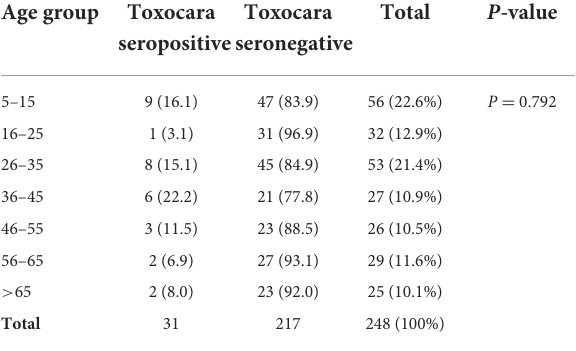
TABLE 1 Age distribution of the individuals according to Toxocara